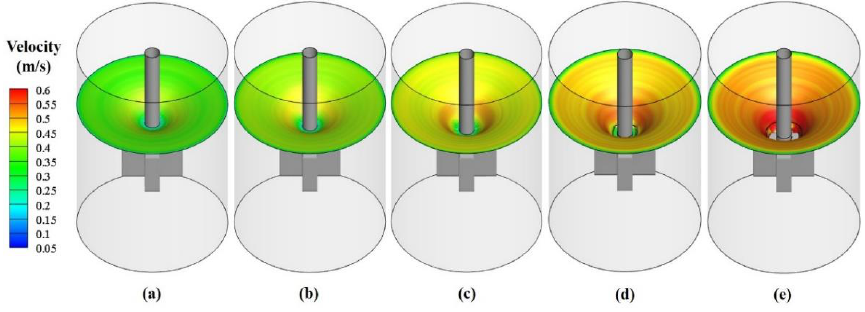
Figure 19. Comparison of gas–liquid interface velocity at different IRSs at ( a ) 180 rpm, ( b ) 200 rpm, ( c ) 220 rpm, ( d ) 240 rpm, and ( e ) 260